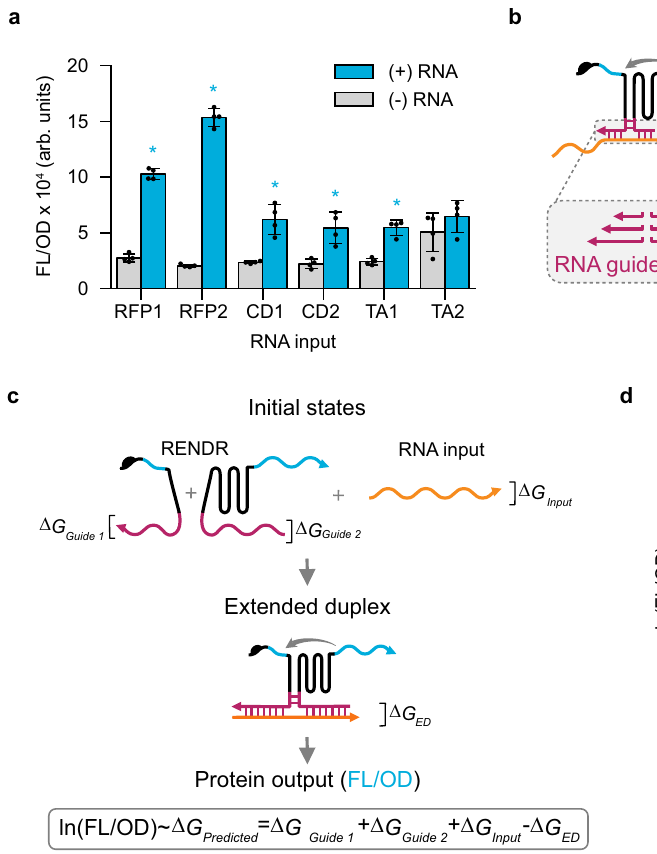
Fig. 3 | RENDR displays input modularity and RNA guide length predictively in fl uences output. a Fluorescence characterization of RENDR variants sensing different RNA inputs from RFP (RFP1/2), CatDe (CD1/2), and TetA (TA1/2). b Schematic of RENDR with varying RNA guide lengths and fl uorescence char- acterization of RENDR variants. Fluorescence characterization (measured in units of fl uorescence [FL]/optical density [OD] at 600nm) was performed on E. coli